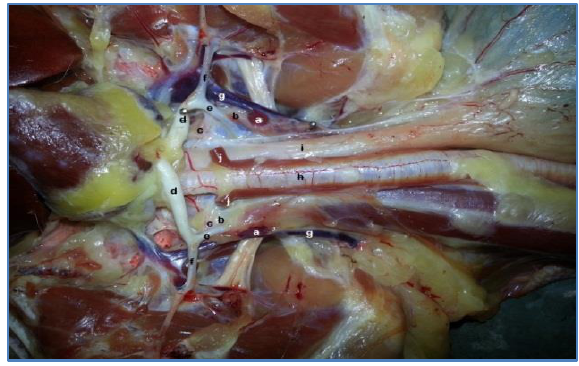
Figure, 1: Photograph in the thoracic inlet of turkey showed: a-Thyroid glands b-Parathyroid glands c- ultimobranchial glands d-Brachiocephalic artery e-Common carotid artery f-Subclavian artery g- Jugular vein h-Trachea i-Esophagus j-Sternotracheal muscle.